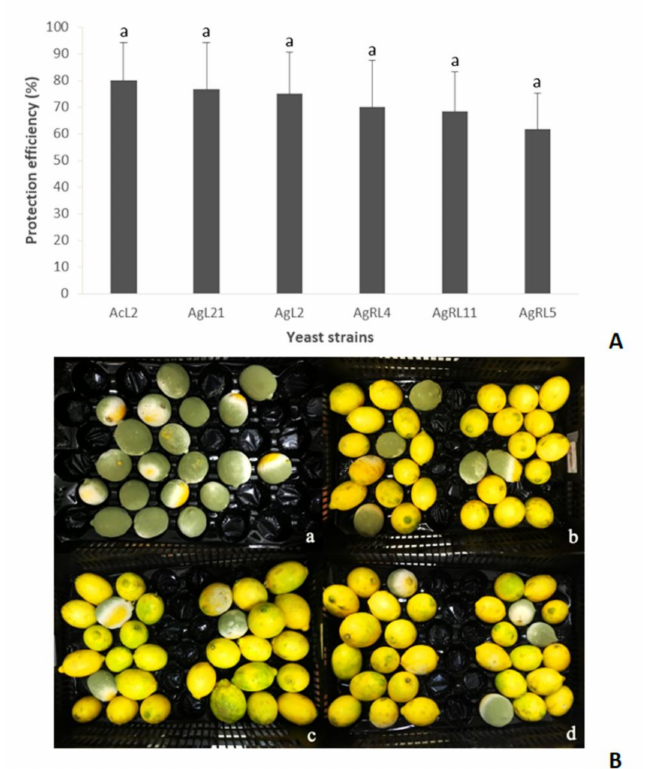
Figure 4. Wound protection efficiencies and biocontrol test of selected candidates. The upper panel ( A ) shows yeast wound protection efficiencies in the in vivo macroscale assay. The best yeast candidates obtained from the microscale assay were evaluated against P. digitatum after 5 days of incubation at 25 ◦ C. Error bars indicate standard deviations. The bottom panel ( B ) represents the in vivo macroscale biocontrol test in lemons. The figure shows wound protection in lemons inoculated only with P. digitatum ( a ), compared to lemons pretreated with yeasts ( b ) AgL21, ( c ) AgL2, and ( d ) AcL2 after 5 days at 25 ◦